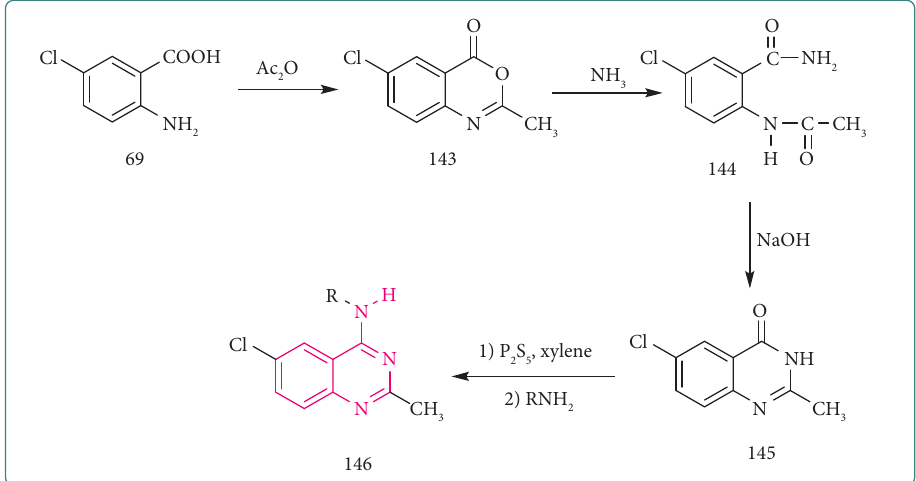
Scheme 26: Synthesis of 4-aminoquinazoline derivatives in the presence of acetic anhydride, NH